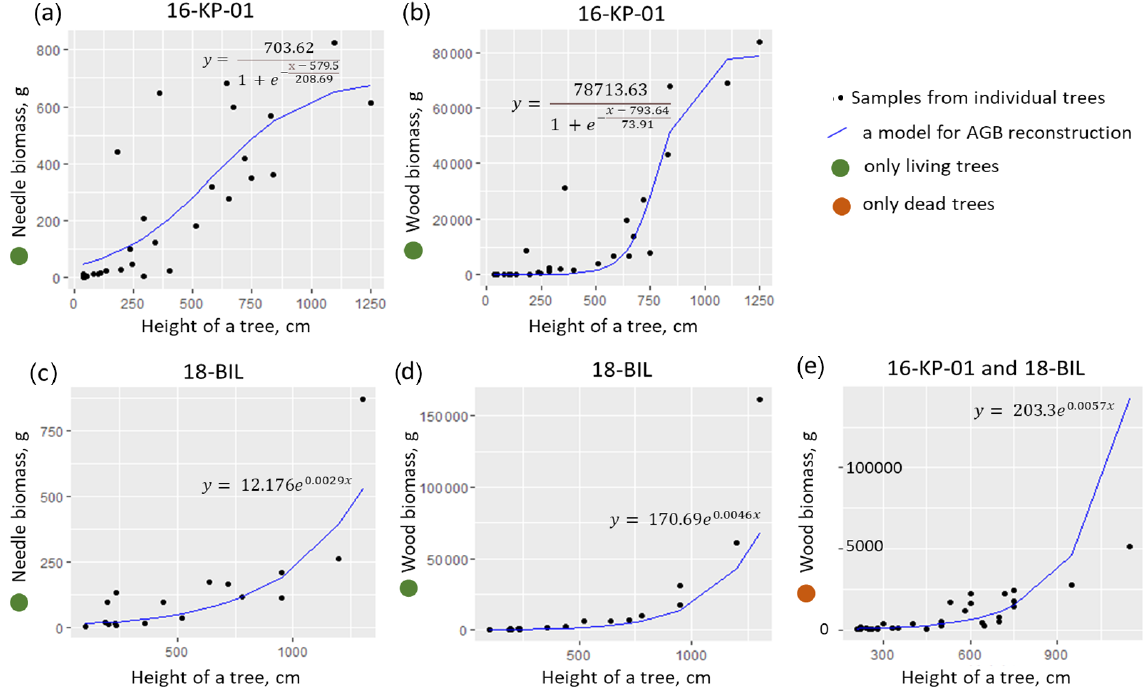
Figure A2. Allometric models, established for larch AGB: (a) for a needle biomass of a living tree in the area 16-KP-01, (b) for a wood biomass of a living tree in the area 16-KP-01, (c) for a needle biomass of a living tree in the area 18-BIL, (d) for a wood biomass of a living tree in the area 18-BIL, and (e) for a wood biomass of a dead tree in both areas.